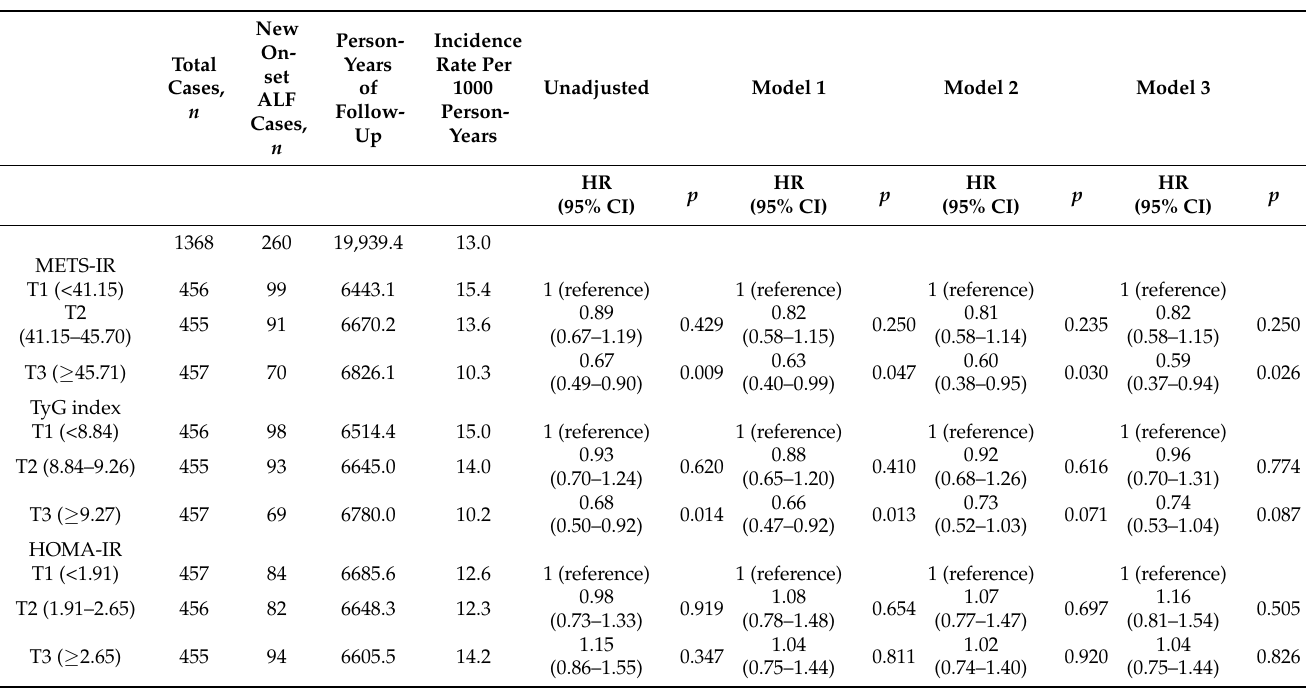
Table 3. Cox proportional hazard regression model for incident ALF according to the tertiles of each insulin resistance